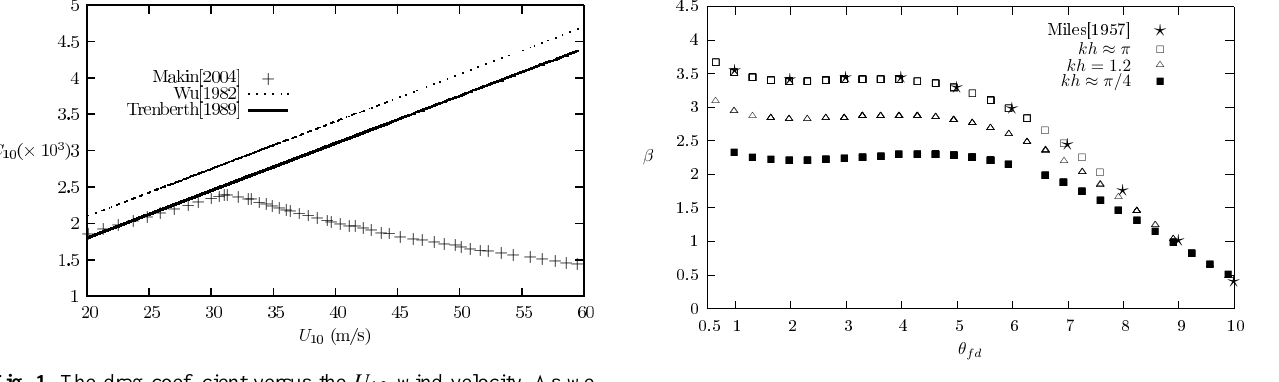
Fig. 2. Miles’ β vs θ fd . For the deep-water limit kh ≈ π our results fit the Miles curve. kh < π/ 4 corresponds to shallow water that is beyond the range of validity of our model. An intermediate value of kh is included, and we see that β is less than in the deep-water